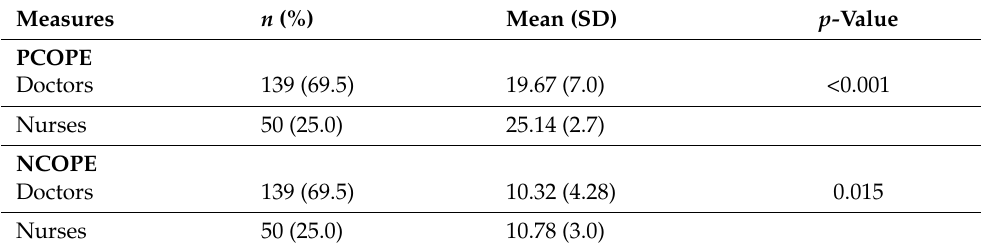
Table 6. Association between occupations with positive and negative brief religious coping scales. ( n =